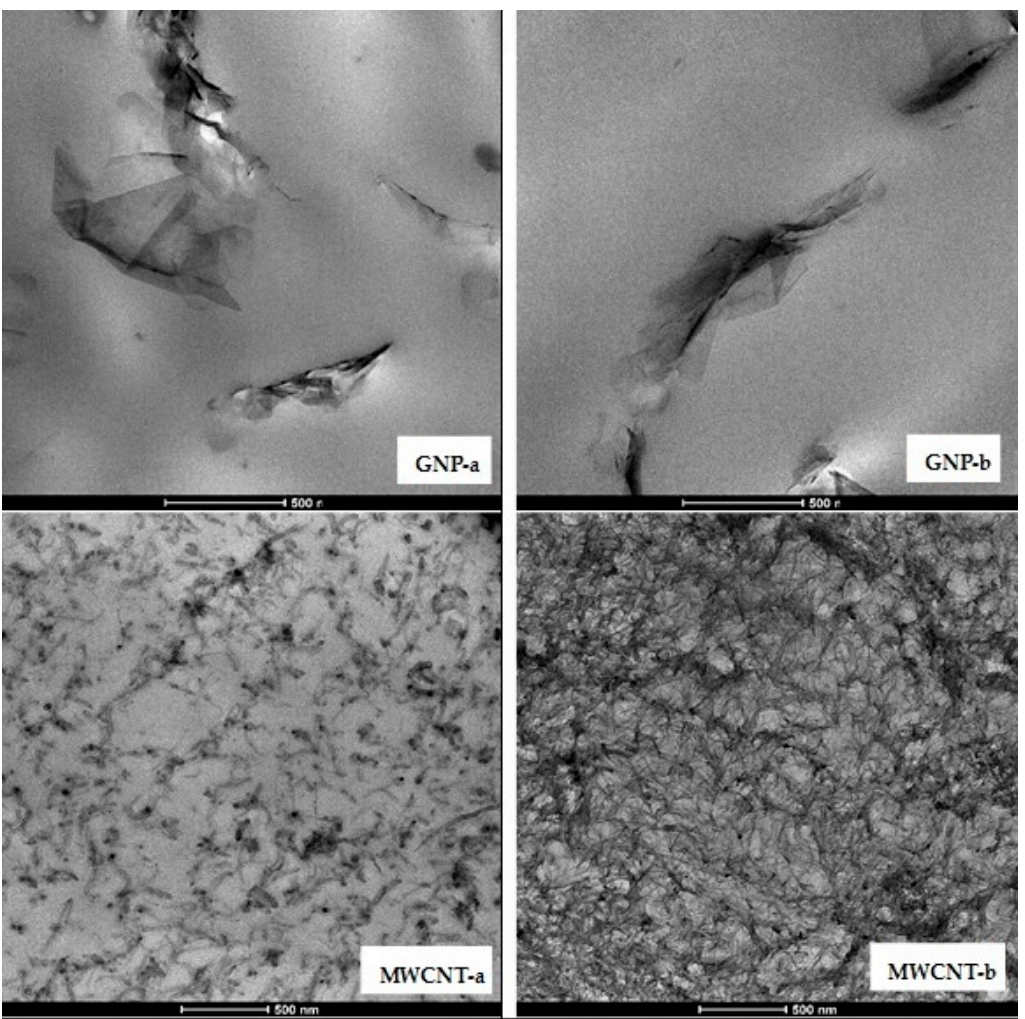
Figure 5. TEM micrographs of 6 wt.% nanocomposites, comparing GNP-a and GNP-b (first line); MWCNT-a and MWCNT-b (second line).